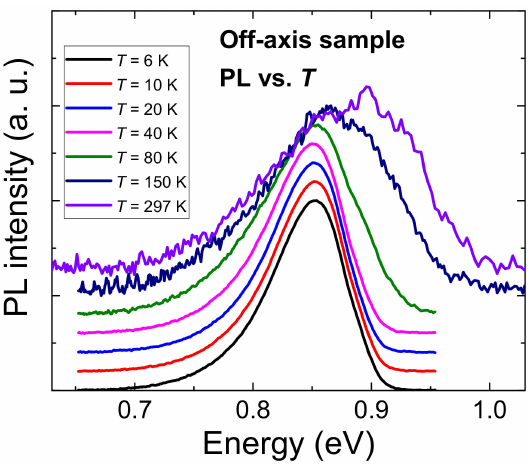
Figure 7. PL spectra of the off-axis sample in the temperature range from 6.5 K to the room tempera- ture. The spectra are shifted in the y -axis for the purpose of a better